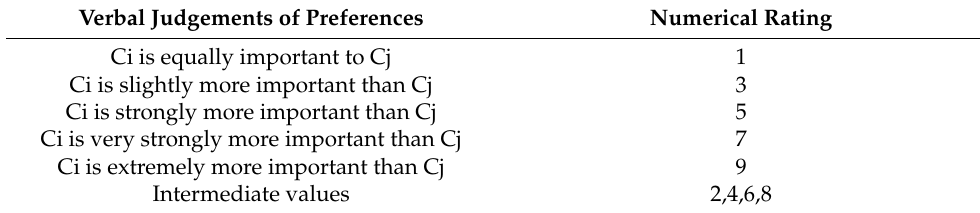
Table 7. Saaty’s pairwise comparison scale.